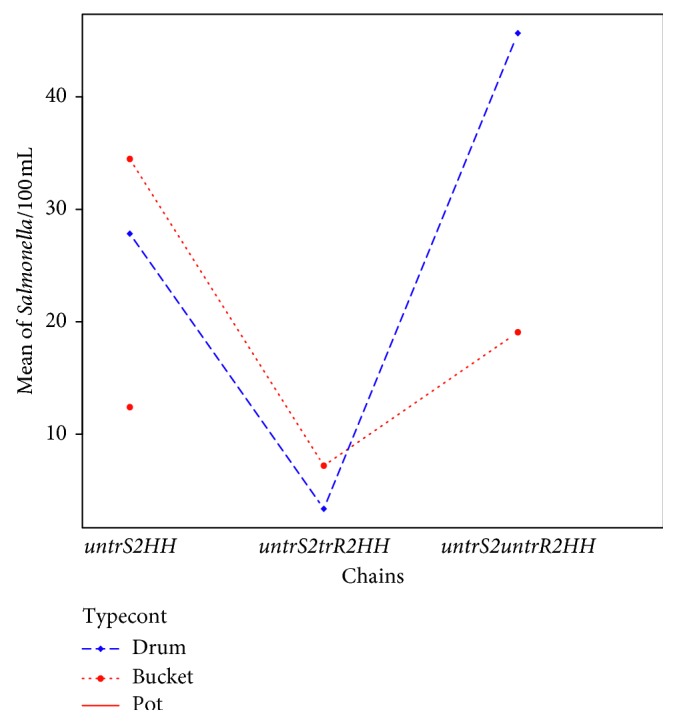
Interaction between container type, water-handling chains, and mean of Salmonella contamination in CFU/100 mls (untrS2HH = untreated source to households; untrS2trR2HH = untreated source to treated reservoir to households; untrS2untrR2HH = untreated source to untreated reservoir to households; typecont = type of container).